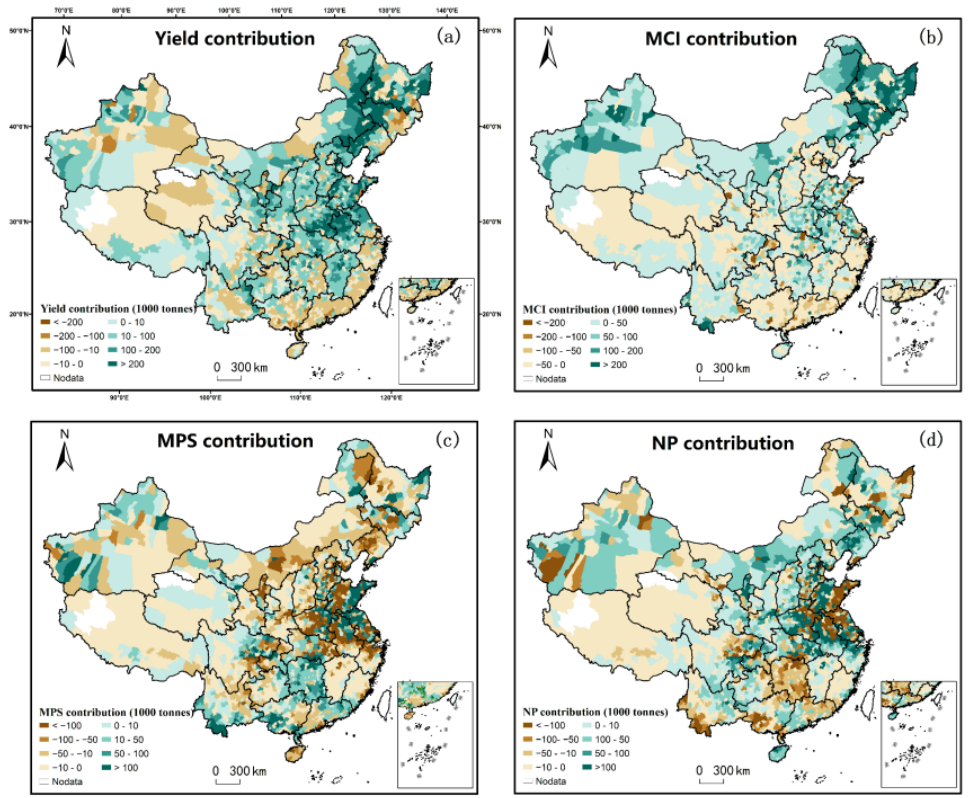
Figure 7. Decomposition of changes in China’s crop production at the county scale with the individual contributions of the factors being given in the subpanels, ( a ): Yield, ( b ): Multiple Cropping Index ( MCI ), ( c ): Mean Parcel Size ( MPS ), ( d ): Number of Parcels (NP).